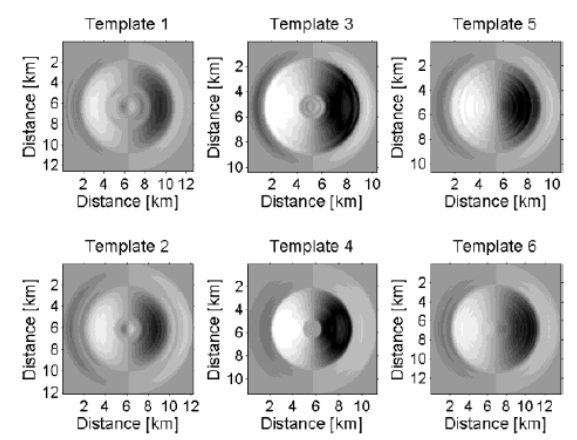
Figure 2. Basic crater templates. Templates 1 and 2: craters with a small central mound. Templates 3 and 4: craters with flat floor. Templates 5 and 6: simple bowl-shaped craters (Grumpe and Wöhler,